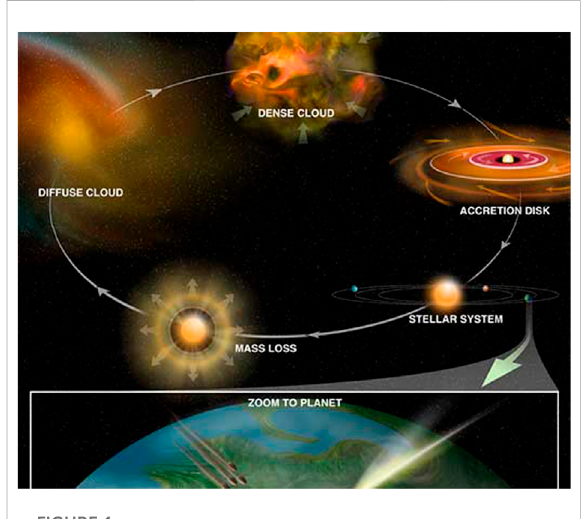
FIGURE 1 Lifecycleofmatterinspace:fromdiffusecloudstostellarand planetary formation. Credit Bill Saxton,